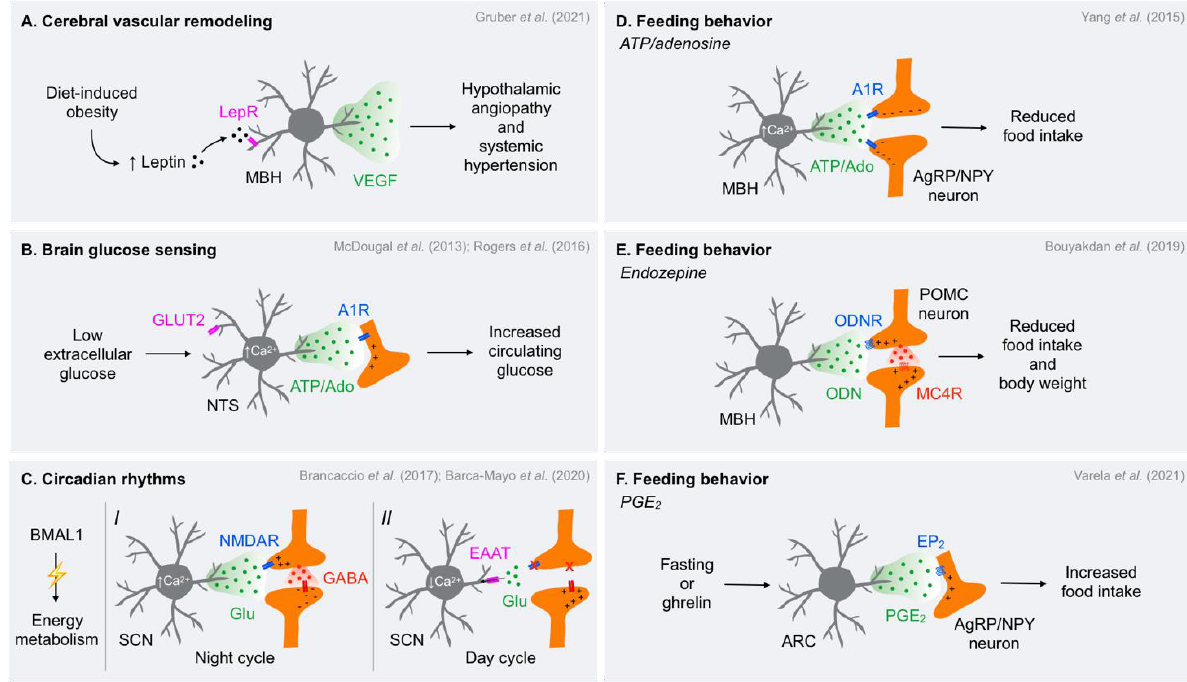
Figure 2. The action of astrocyte-released gliotransmitters in the control of systemic metabolism. ( A ) Diet-induced obesity promotes hyperleptinemia, which hyperactivates leptin receptors (LepRs) in astrocytes from the mediobasal hypothalamus (MBH) and leads to the release of vascular endothelial growth factors (VEGFs), promoting hypothalamic angiopathy and systemic hypertension; ( B ) Astrocytes from the brainstem nucleus tractus solitarius (NTS) sense extracellular glucose concentration drops via glucose transporter type 2 (GLUT2) and respond with ATP/adenosine (Ado) release, leading to the activation of adenosine A1 receptors (A1Rs) in neighboring neurons to restore normoglycemia; ( C ) The disruption of the brain and muscle ARNT-like protein-1 (BMAL1) signaling in astrocytes impairs energy metabolism. (I) During the night cycle, astrocytes from the suprachiasmatic nucleus (SCN) show increased Ca 2+ transients, which induce the release of glutamate that binds to N-methyl-D-aspartate receptors (NMDARs) subtype 2C in presynaptic neurons resulting in increased γ -aminobutyric acid (GABA)-mediated neurotransmission; (II) In the day cycle, astrocytes are silent and the glutamate near the synaptic cleft is taken up by astrocytic excitatory amino acid transporters (EAATs), therefore reducing the GABAergic tone onto SNC neurons; ( D ) Ca 2+ rises in astrocytes from the MBH promote the release of ATP/Ado that acts in presynaptic neurons and/or postsynaptic agouti-related protein/neuropeptide Y (AgRP/NPY) neurons to reduce food consumption; ( E ) Astrocytes from the MBH release the endozepine octadecaneuropeptide (ODN), which acts on its receptor in proopiomelanocortin (POMC) neurons, leading to the activation of the upstream melanocortin-4 receptor (MC4R) signaling to reduce food intake and body weight; ( F ) Fasting/ghrelin may activate astrocytes from the arcuate nucleus of the hypothalamus (ARC), promoting the release of prostaglandin E 2 (PGE 2 ) to increase the activity of AgRP/NPY neurons, ultimately inducing food intake.